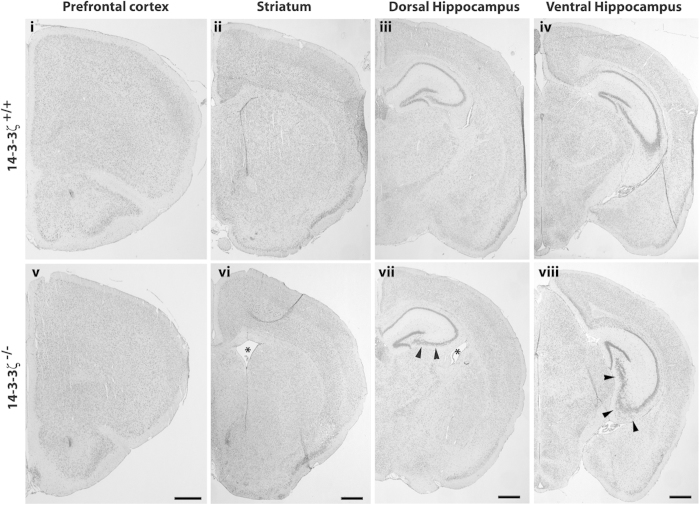
Structural brain defects in 14-3-3ζ-deficient mice.Nissl staining of coronal brain sections from 5 month old adult 14-3-3ζ+/+ (i–iv) and 14-3-3ζ−/− mice (v–viii). Images show that lamination of the prefrontal cortex (i and v), motor cortex and cingulate cortex (i–iii and v–vii), thalamus (iii and vii) and amygdala (iii and vii) are normal in 14-3-3ζ−/− mice. Lamination defects were identified in the dorsal and ventral hippocampus of 14-3-3ζ−/− mice (iii and vii, iv and viii respectively; arrowhead). The lateral ventricle was also enlarged in 14-3-3ζ−/− mice (ii–iii and vi–vii; asterisk). Scale bar = 100 μm.